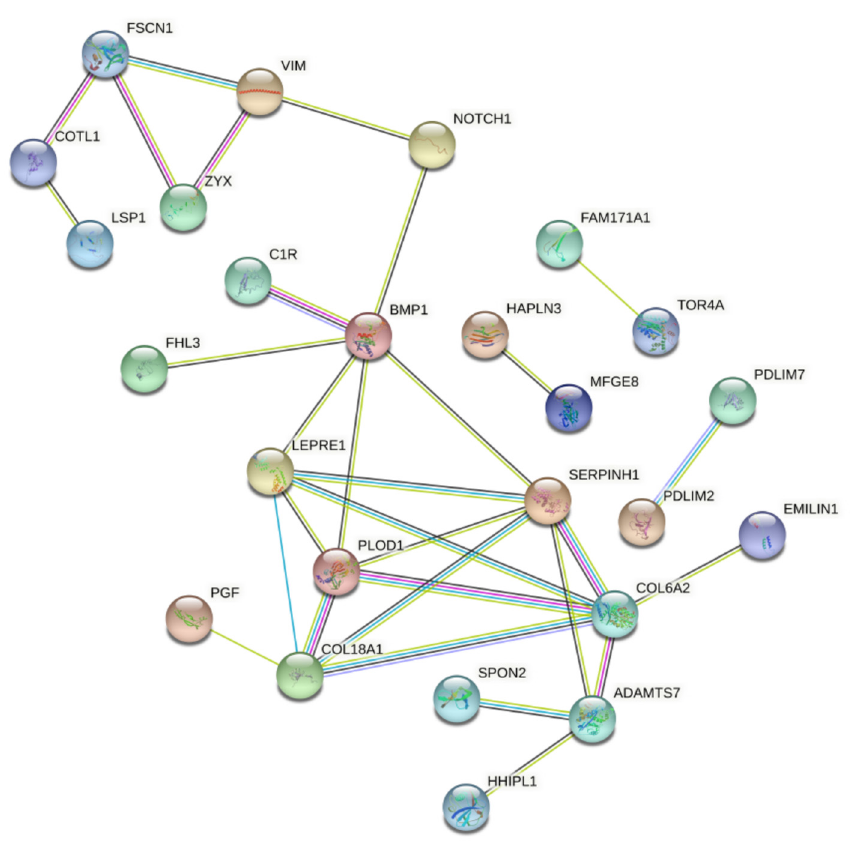
Figure 2. Protein-protein interaction network in FSCN1 high compared to FSCN1 low BRCA. Con- structed protein-protein interaction network of 60 enriched genes in FSCN1 high ( n = 534) vs. FSCN1 low ( n = 545) breast cancer patients from TCGA dataset. Nodes represent proteins and different line intensities denote the type of evidence for the interaction. Statistical analysis results for the network: number of nodes: 59, number of edges: 28; average node degree: 0.94; average local clustering coef- ficient: 0.26; expected number of edges: 7; PPI enrichment p -value = 5.7–10.